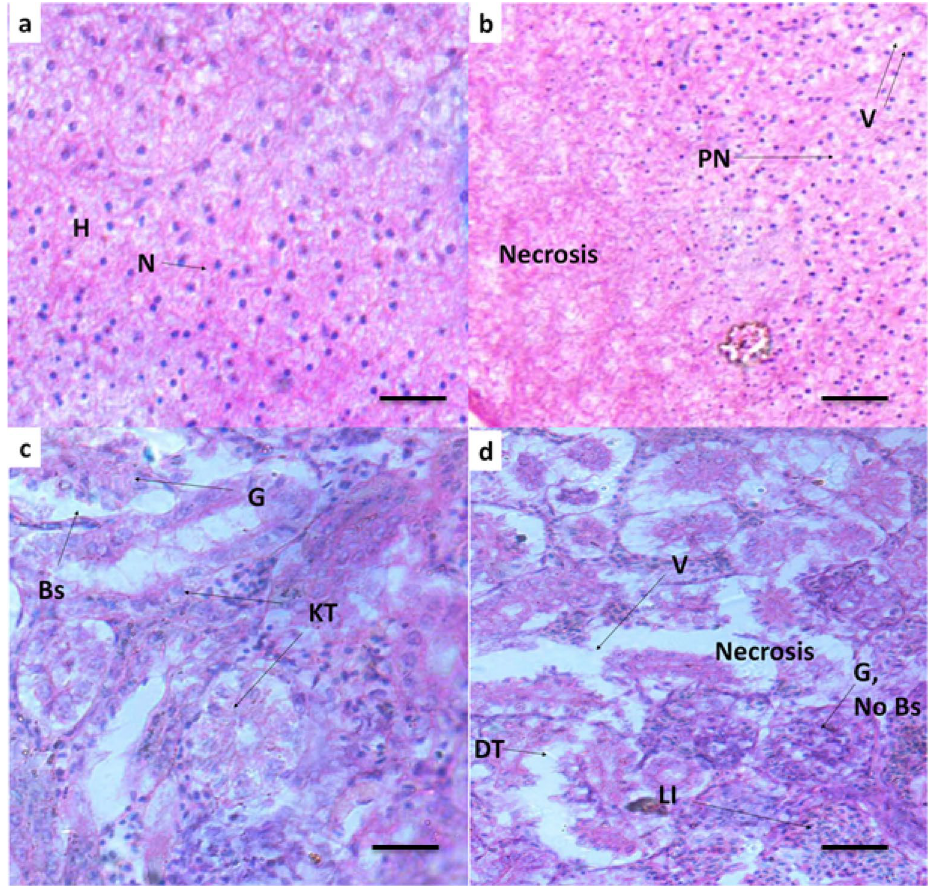
Figure 1. Histopathology of liver and kidney of O. niloticus inhabiting in reference and polluted water. ( a ) Reference liver; ( b ) Liver of exposed fish; H (hepatocyte), N (Nucleus), Necrosis, V (vacuolization). ( c ) Reference kidney; ( d ) Kidney of exposed fish; G (glomeruli), Bs (bowman’s space), KT (kidney tubule), DT (damaged tubule), Necrosis, LI (Leucocyte infiltration). Magnification = 40X; Scale bar = 20